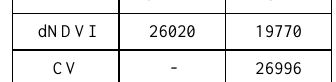
Table 15. Number of changed object